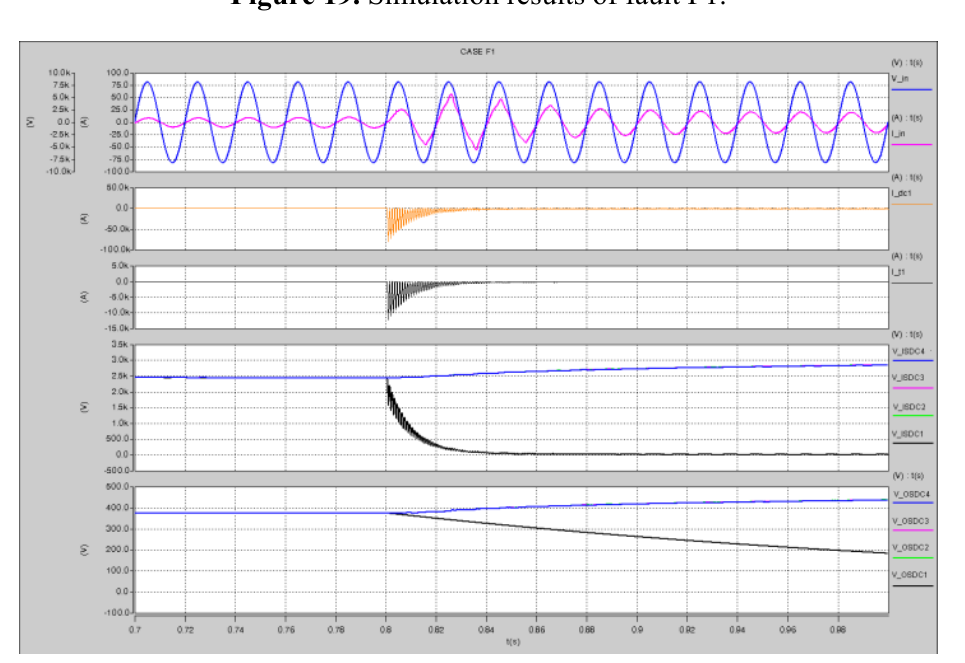
Figure 19. Simulation results of fault